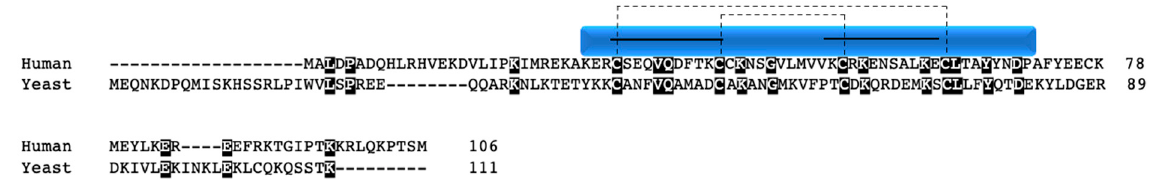
Figure 5. CMC1. Alignment of human and yeast CMC1 protein sequences. Black boxes indicate conserved residues. Human sequence annotation is as follows: Blue box indicates the CHCH domain. Solid black lines indicate the twin CX 9 C motif. Dashed lines indicate the cysteine pairs that form structural disulfide bonds.